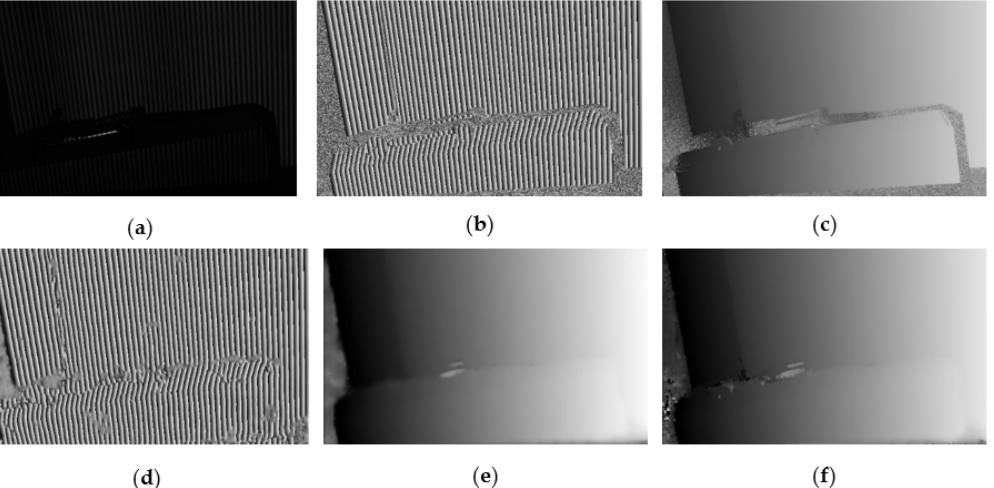
Figure 8. Results for one fringe image in the test set: ( a ) fringe image; ( b ) ground truth wrapped phase map; ( c ) ground truth absolute phase map; ( d ) predicted wrapped phase map; ( e ) predicted absolute phase map; ( f ) refined absolute phase map.